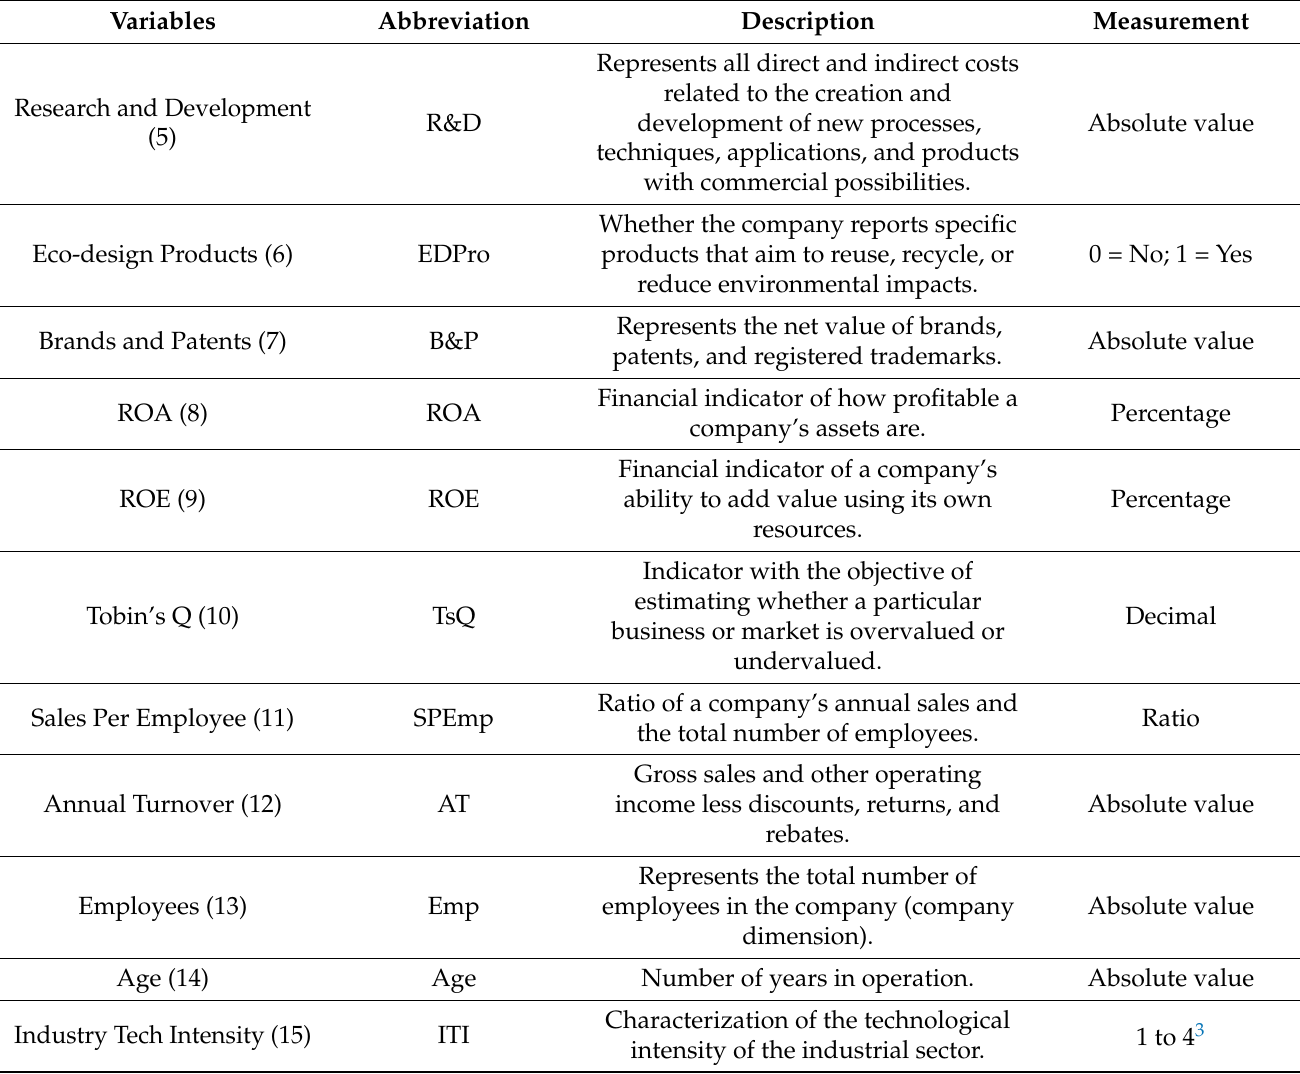
Table 5. Description of corporate and innovative performance